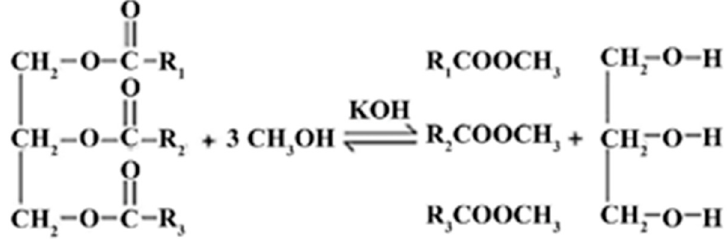
Figure 2. Transesterification of triglycerides with alcohol and catalyst [18].